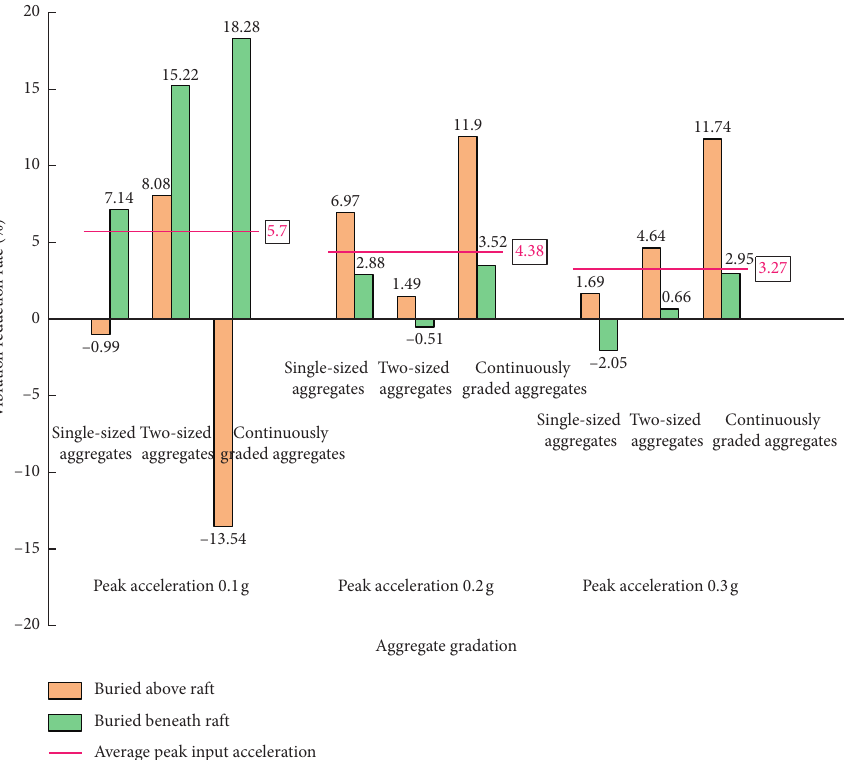
Figure 9: Vibration reduction rates of the clay layer at different parameter